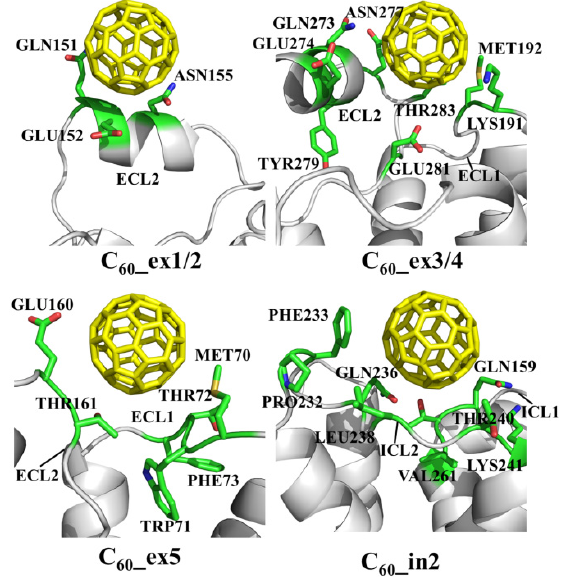
Figure 4. Snapshots of the C 60 _ex1/2, C 60 _ex3/4, C 60 _ex5 and C 60 _in2 systems show that the key amino acids of the ECL1 and ECL2 interact with the monomeric fullerenes at the extracellular and intracellular sides.